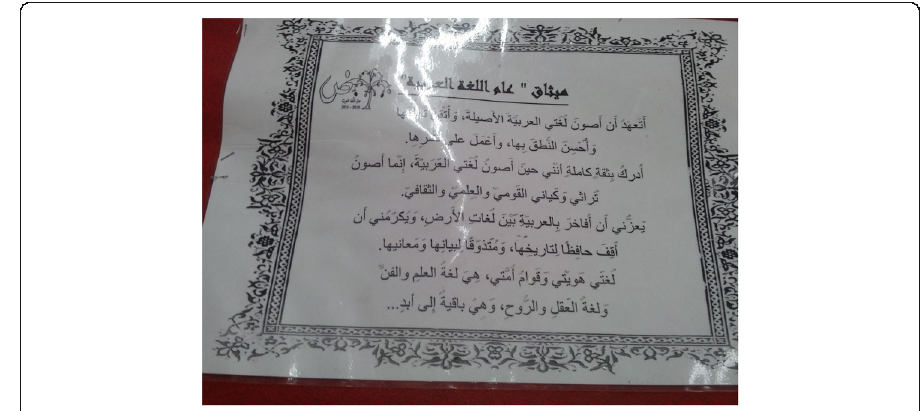
Fig. 10 A symbolic sign concerning the Arabic language